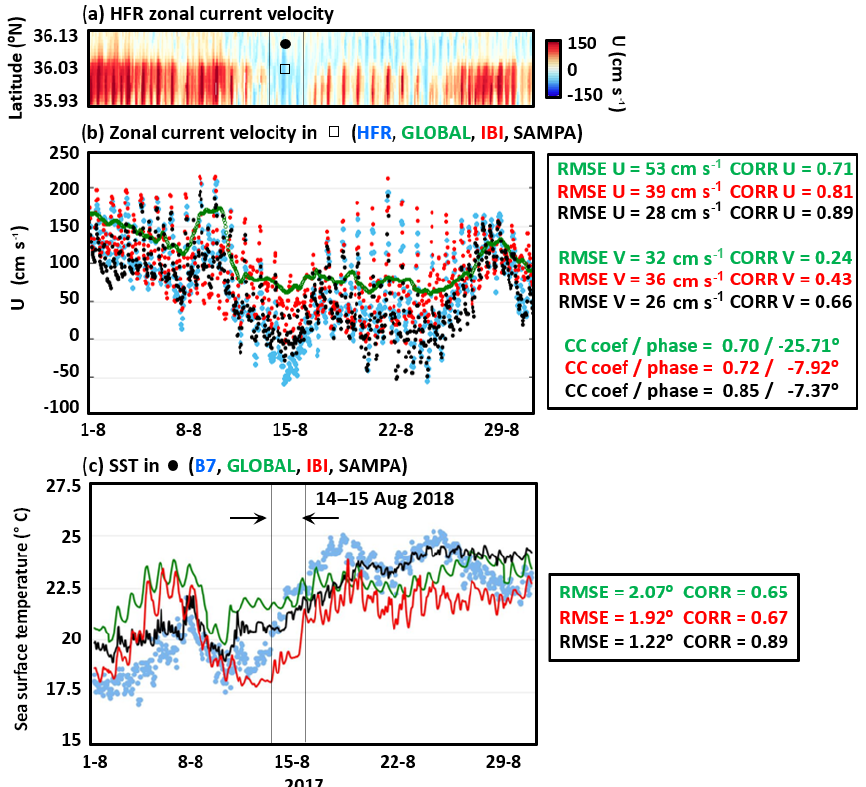
Figure 12. (a) Monthly Hovmöller diagram of HFR-derived zonal current velocity at the selected transect in the Strait of Gibraltar for August 2017. Red (blue) colour represent eastward (westward) flow. A complete Atlantic inflow reversal episode marked with black box for the 14–15 August; (b) monthly times series of zonal current velocity at the midpoint of the transect (represented by a black square in the Hovmöller diagram) provided by HFR (blue dots), SAMPA (black dots), IBI (red dots), and GLOBAL (green dots); (c) monthly time series of SST provided by B7 buoy (blue dots), SAMPA (black line), IBI (red line), and GLOBAL (green line). Monthly skill metrics derived from observation–model comparison are gathered in black boxes on the